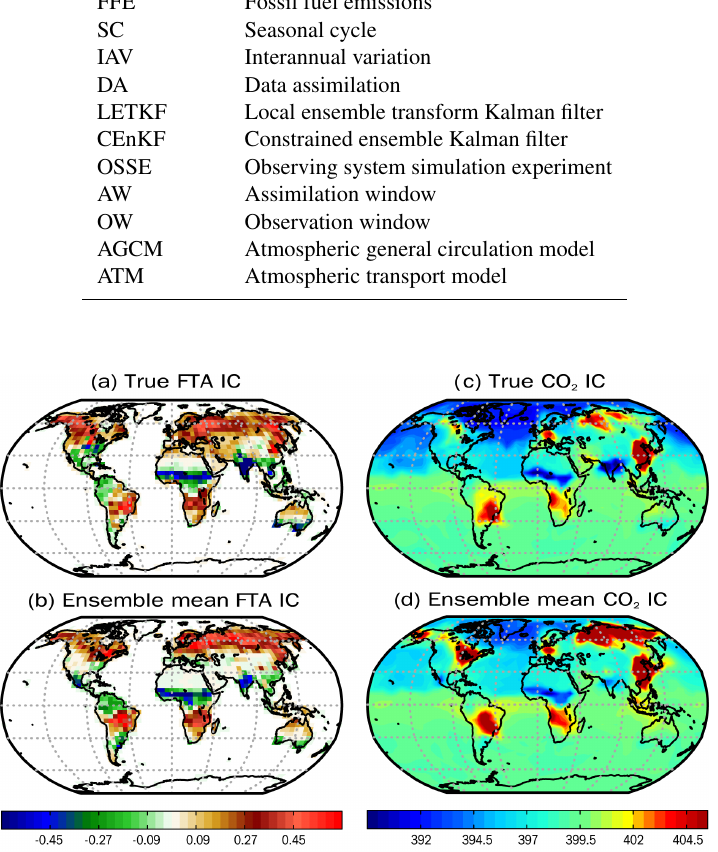
Figure A1. The initial FTA and surface CO 2 condition of the truth (a, c) and the ensemble mean first guess (b, c) on 1 October 2014.